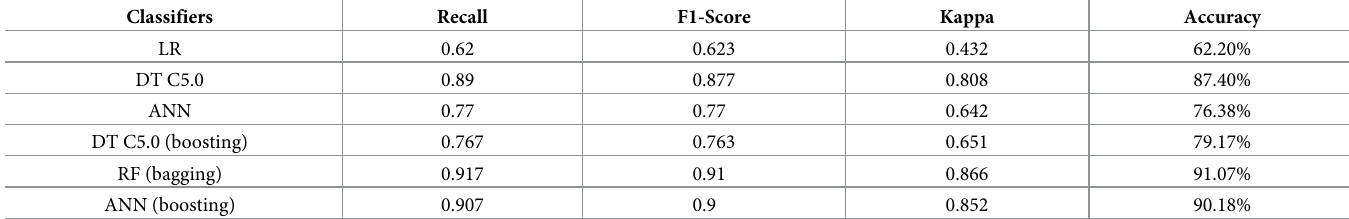
Table 7. Performance comparison of ternary classification models with different classifiers.